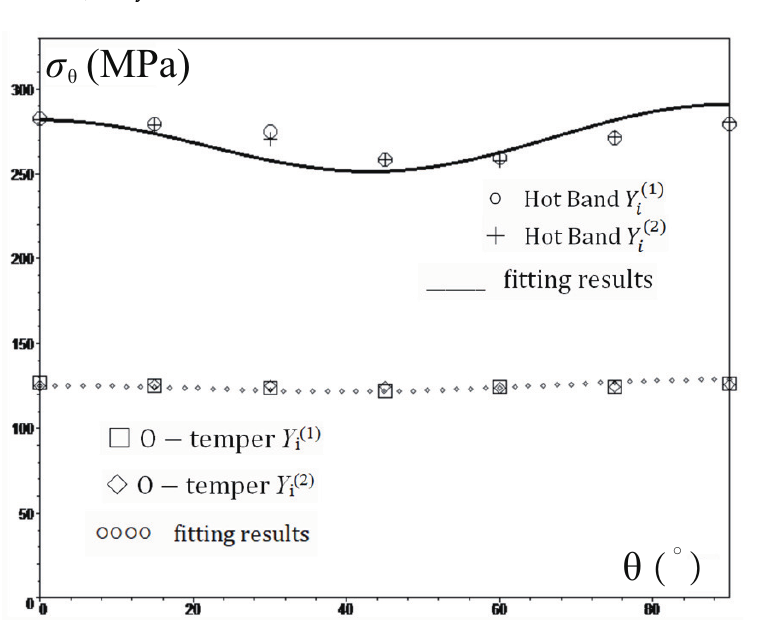
Figure 2. Experimental data of Xiang and fitting results of